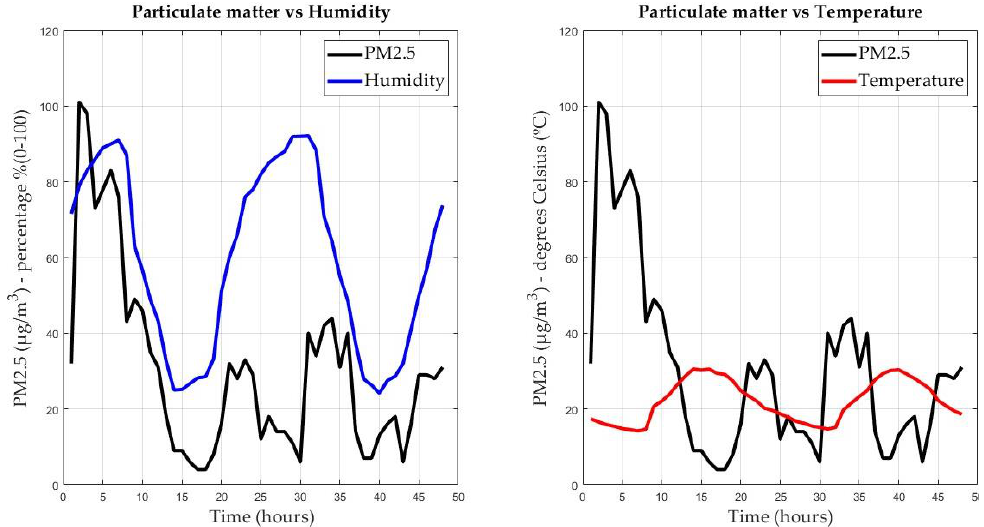
Figure 4. Relationship between particulate matter, humidity, and temperature.